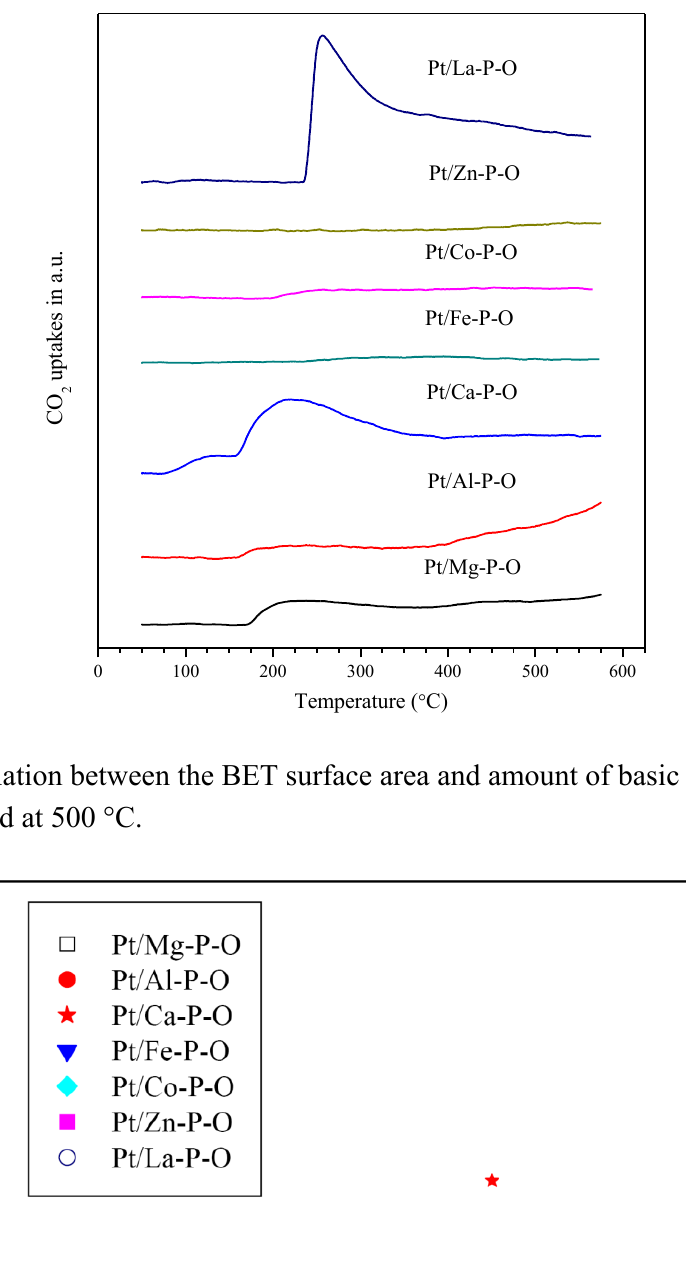
Figure 6. CO 2 -TPD profiles of Pt/M-P-O calcined at 500 °C and then pretreated in 4% H 2 at 300 °C.